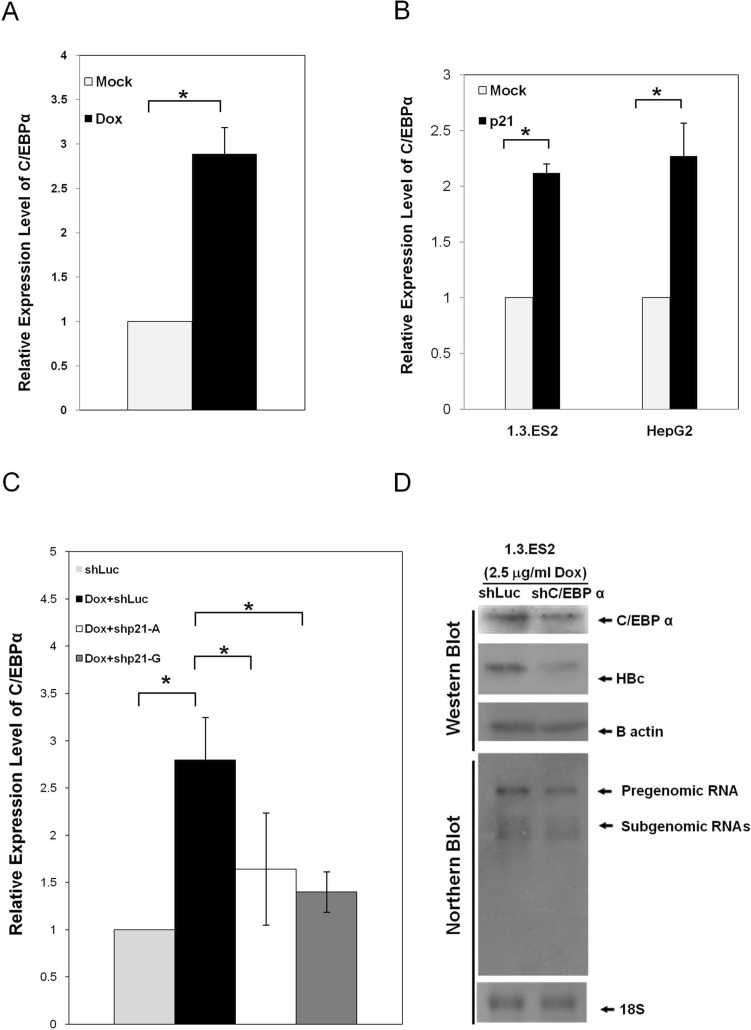
The elevation of C/EBPα by doxorubicin and its impact on activation of HBV replication.(A) The elevation of C/EBPα by doxorubicin. 1.3.ES2 was treated with doxorubicin for 1 hour and then the culture medium was replaced with fresh culture medium for three days. Next, total RNA was harvested in order to carry out quantitative RT-PCR. (B) The elevation of C/EBPα by p21 over-expression. 1.3.ES2 cells or HepG2 cells over-expressing p21 were harvested for analysis of the expression level of C/EBPα by quantitative RT-PCR. (C) The role of p21 in doxorubicin-mediated C/EBPα elevation. 1.3.ES2 cells were infected with lentivirus expressing p21 shRNA. Twenty-four hours post-infection, cells were treated with doxorubicin for 1 hour, which was followed by replacing the culture medium with fresh culture medium. Culturing was then continued for 3 days. Next, total RNA was harvested for analysis of the expression level of C/EBPα by quantitative RT-PCR. The expression level of B2M was used as a reference control. (D) 1.3.ES2 cells were infected with lentivirus expressing C/EBPα shRNA for 24 hours, treated with doxorubicin for 1 hour, and this was followed by culturing in fresh culture medium for 3 days. The expression levels of HBV transcripts, HBcAg and C/EBPα were analyzed by Northern blot and Western blot.analysis, *, P < 0.01, 2-sided unpaired t test.